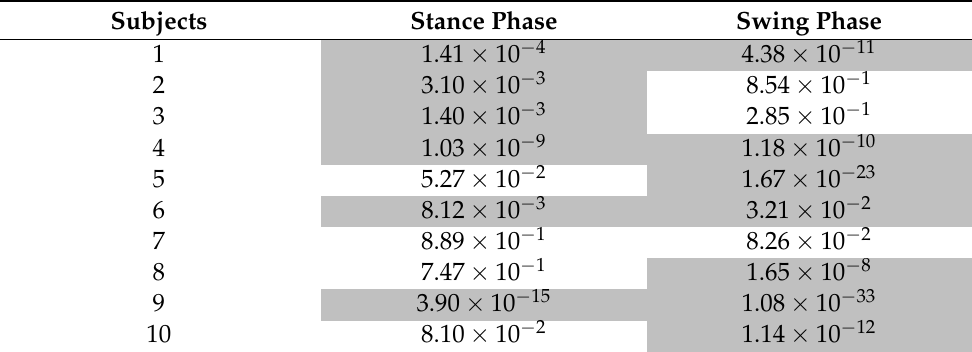
Table 6. The probability value ( p -value) of each subject for the stance and swing phases. The highlighted cells indicate a statistical difference ( p < 0.05) calculated through Student’s t